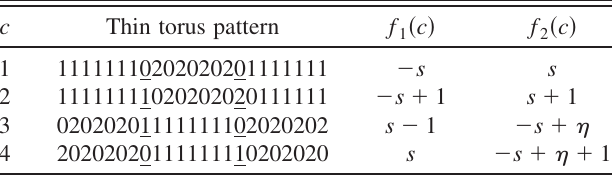
TABLE I. Thin torus patterns for a two–domain-wall Moore- Read state, and the offset functions of those domain walls. The latter are defined in terms of the shift parameter s , and relate to orbital positions 2 n (underlined) via domain-wall positions a i i ¼ 2 n þ f ð c Þ . Some offset functions depend on the particle a i i i number parity (cid:7) , with (cid:7) ¼ 0 ( (cid:7) ¼ 1 ) when N is even (odd). Thin torus